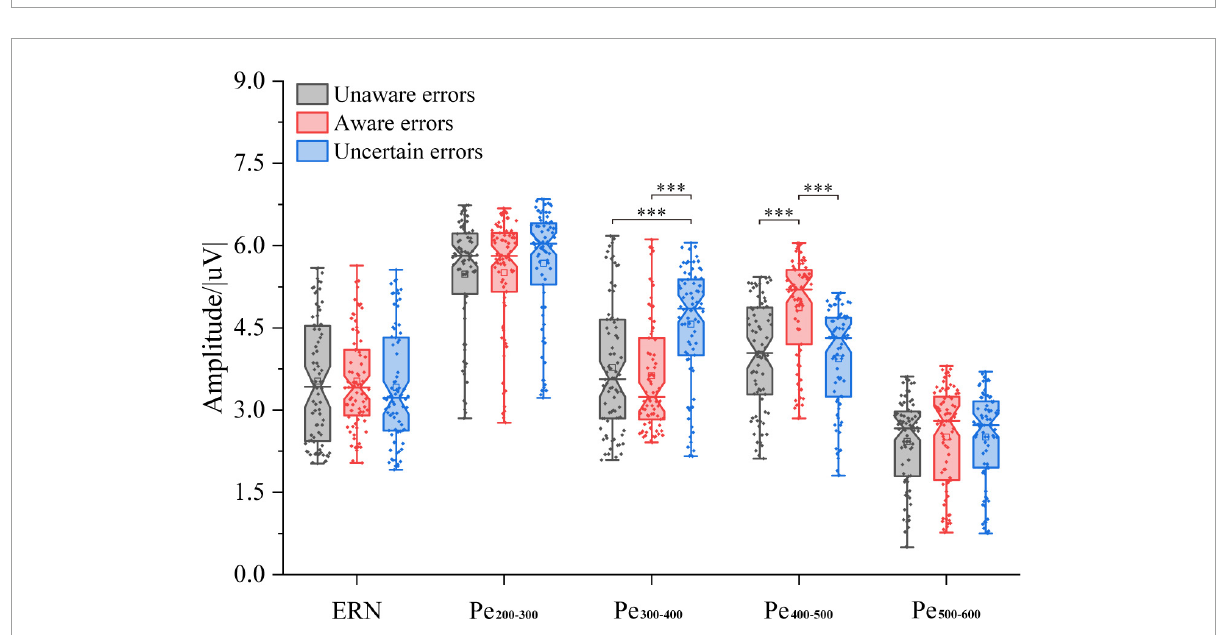
FIGURE3 ERP amplitude of multiple error awareness in volunteers’ ground experiment ( n = 78). The squares in the box plots indicated the mean values, the horizontal lines indicated the medians, and both ends indicated the maximum and minimum values ( ∗∗∗ p < 0.0001).